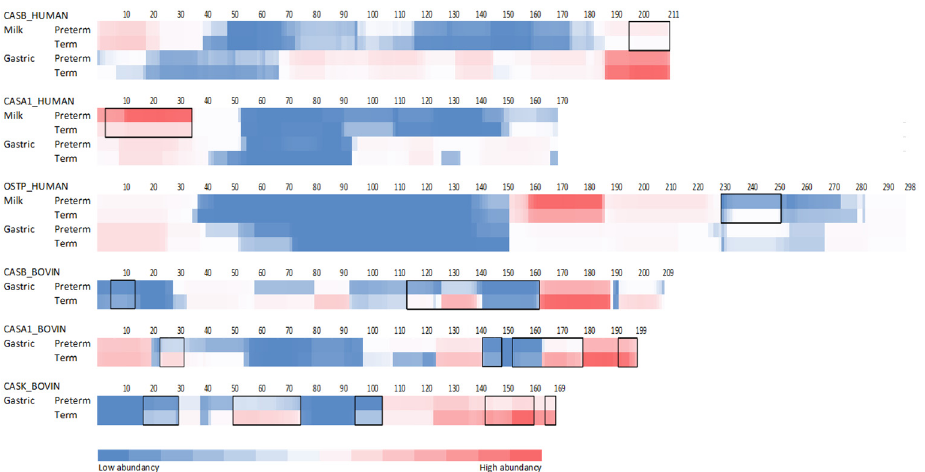
Figure 5. Volcano plots depicting fold change in individual peptide intensity ( x- axis, logarithmic) and p- value ( y -axis, logarithmic) between term and preterm infant milk and gastric samples. Filled circles indicate the peptide was significantly different between preterm and term infants ( p < 0.05), whereas the hollow circles are non-significant.